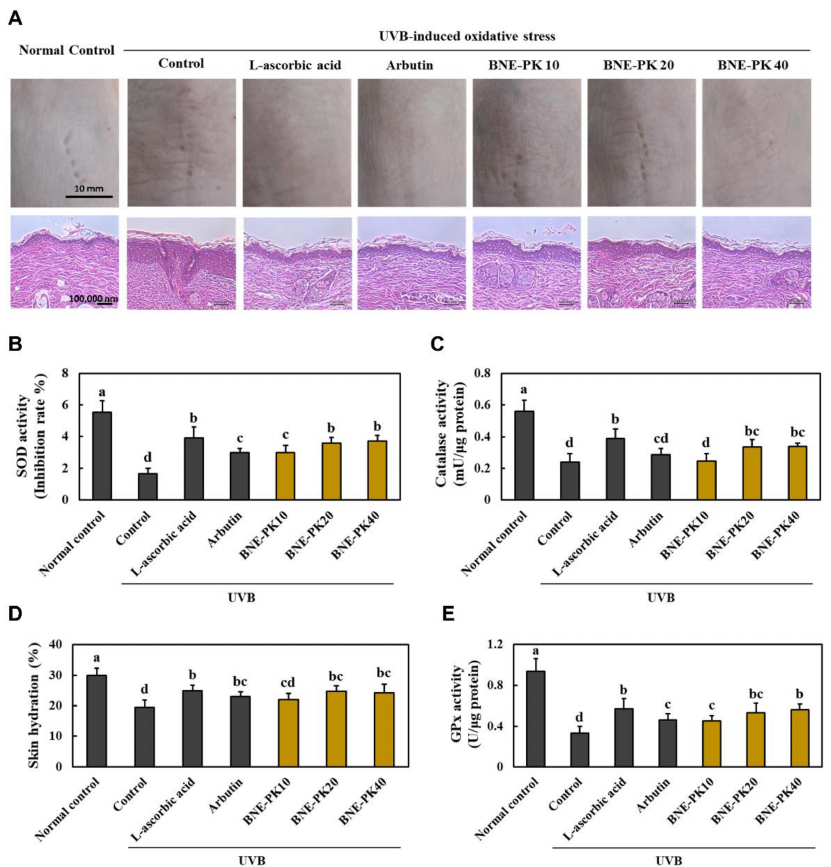
Figure 2. Effects of BNE-PK on morphological and histopathological changes ( A ), skin hydration ( B ), and antioxidant activities of SOD ( C ), catalase ( D ), and GPx ( E ) in the dorsal skin of ultraviolet B (UVB)-irradiated hairless mice. Normal control ( − UVB), control (+UVB), L-ascorbic acid (positive control 1; +UVB with dietary supplementation of L-ascorbic acid at 200 mg/kg/body weight [bw]), arbutin (positive control 2; +UVB with dietary supplementation of arbutin at 200 mg/kg/bw), BNE-PK 10 (+UVB with dietary supplementation of BNE-PK at 10 mg/kg/bw), BNE-PK 20 (+UVB with dietary supplementation of BNE-PK at 20 mg/kg/bw), and BNE-PK 40 (+UVB with dietary supplementation of BNE-PK at 40 mg/kg/bw). Values are presented as mean ± SD. Different letters indicate a significant difference, with p < 0.05, as determined with Duncan’s multiple range